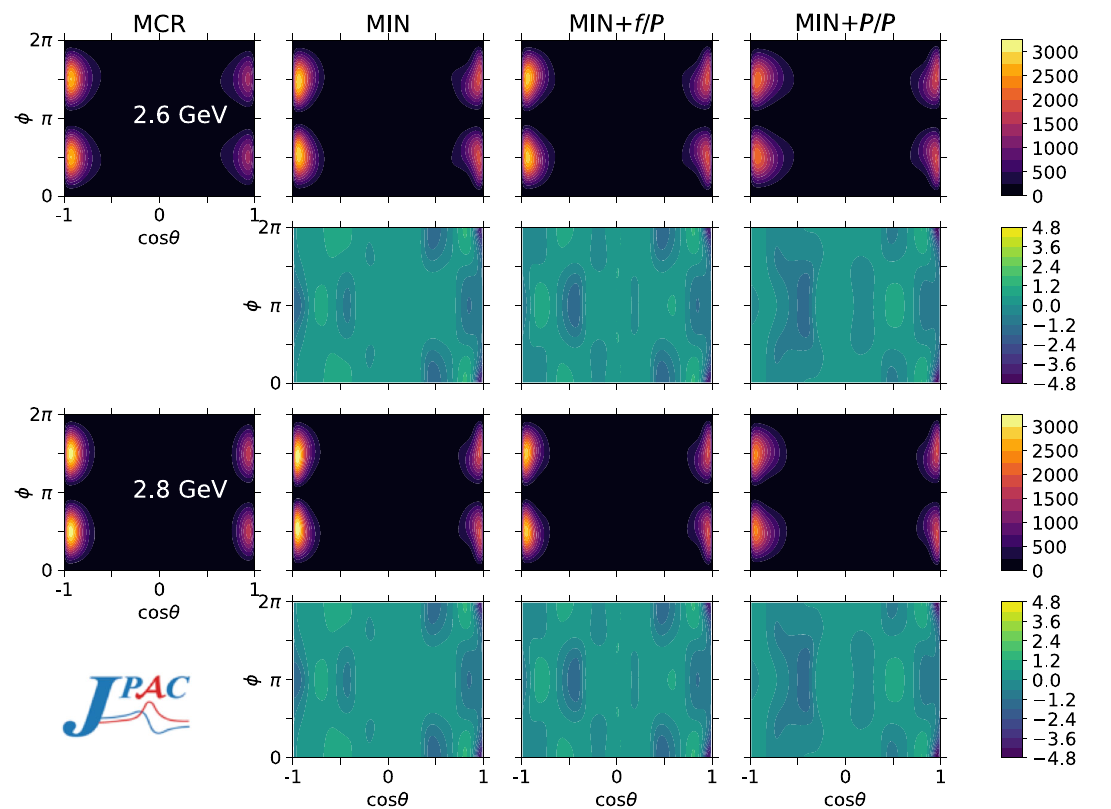
Fig. 14 Examples of ηπ density plots for ¯ I Exp ( m ηπ ,(cid:4)) , ¯ I Th ( m ηπ ,(cid:4)) , and D ( m ηπ ,(cid:4)) defined in Eq. (15). The upper two rows displays refer to m ηπ = 2 . 6GeV, while the lower ones to m ηπ = 2 . 8GeV. In the second and fourth rows D ( m ηπ ,(cid:4)) shows where the main discrepan- cies between theory and experiment appear. Most of its structures are located in the small and intermediate | cos θ | regions, where the models